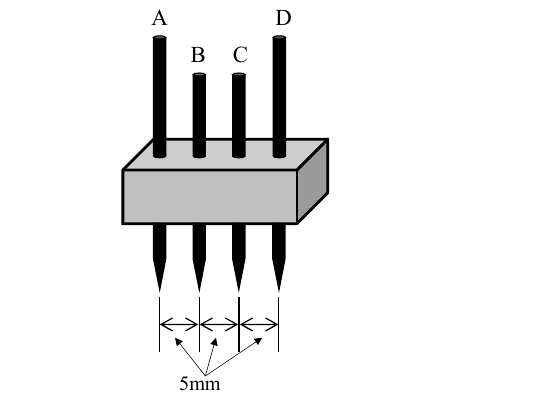
Figure 7. Four terminal probes used for measuring resistivity. Terminals A to D are needles of the same shape. Current flowed from A to D or from D to A, while the voltage was measured between B and C.